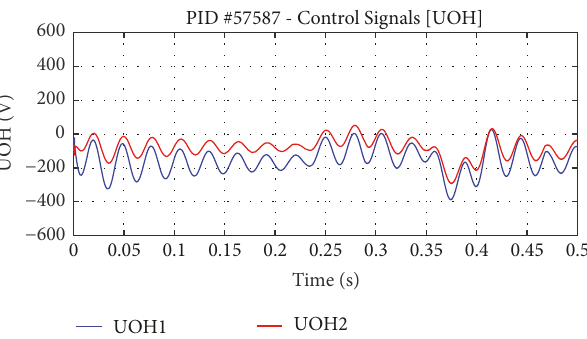
Figure 16: PID control signal (Shot